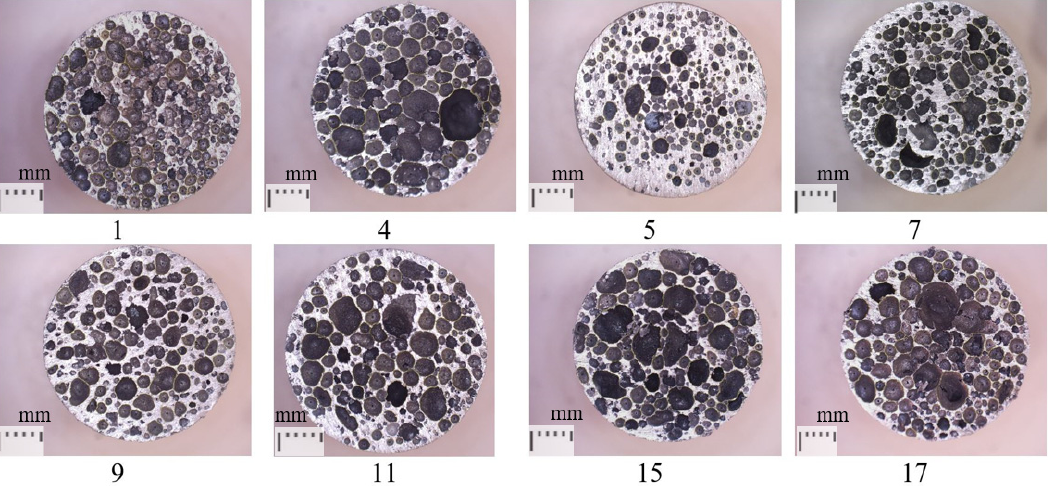
Figure 7. Different pore morphologies for eight samples randomly selected from the experimental plan (the numbers below photos denote experimental points).